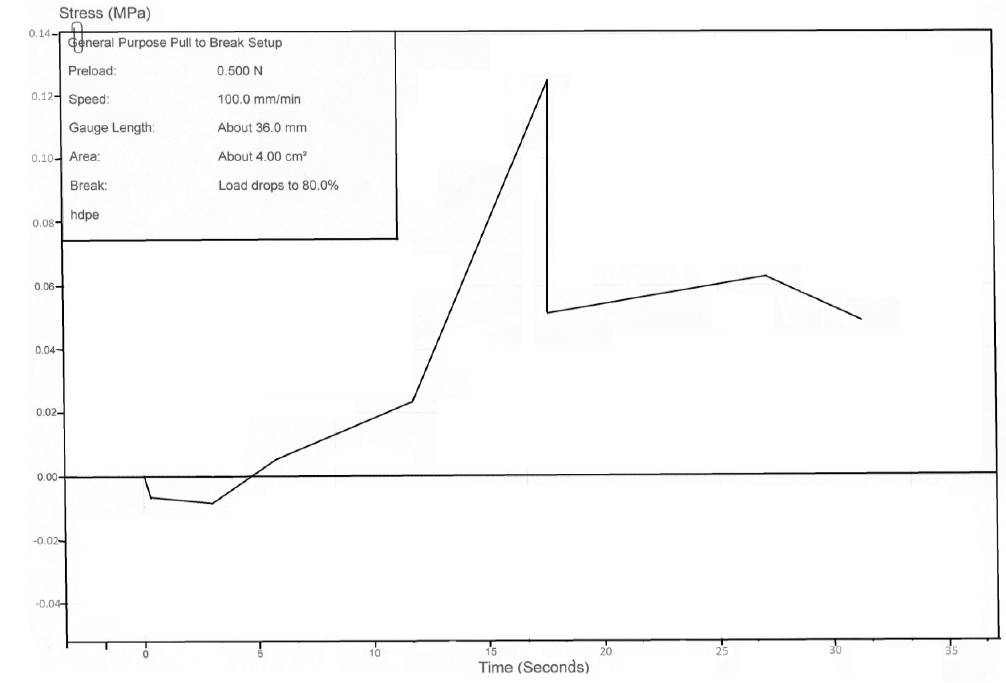
Figure 2. Graph depicted of the tensile tester when the sample was pulled apart with a speed of 100 mm/min for samples drenched in concentrated sulfuric acid for 60 s. The tensile stress in the string increased until the PDMS sample broke away after which the tensile stress dropped